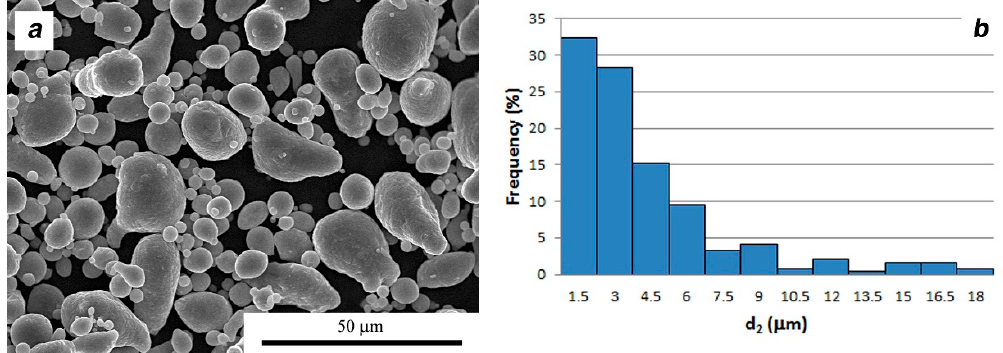
Figure 1. Morphology ( a ) and particle size distribution ( b ) of AA6061 powder.